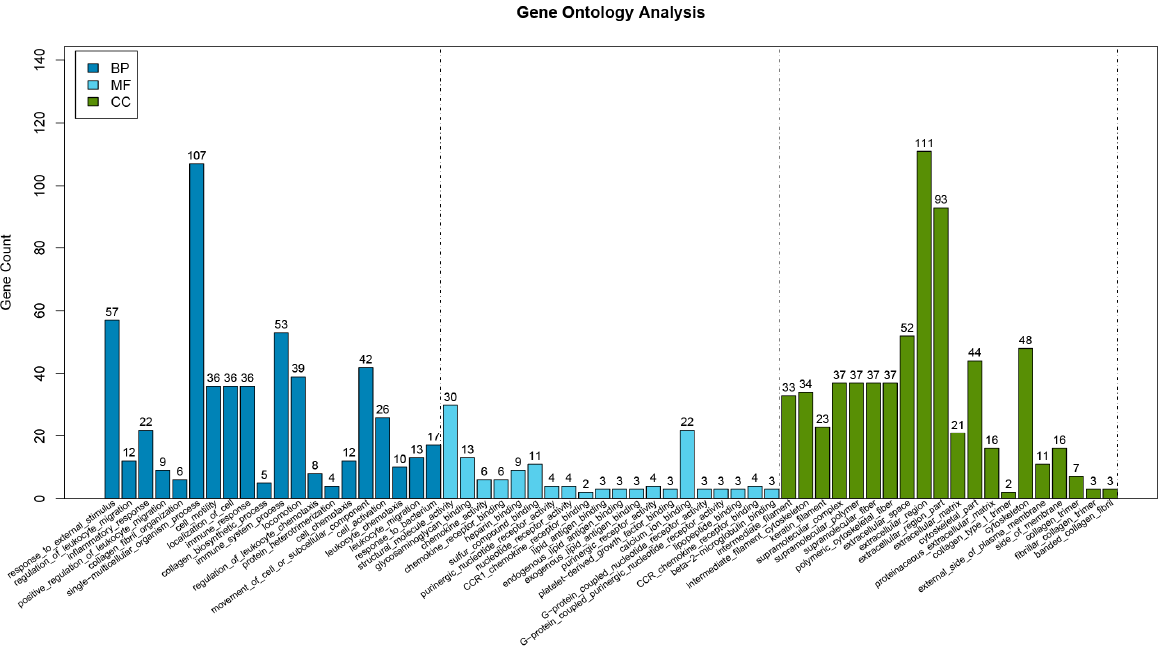
Figure 8. GO classification of differentially expressed lncRNAs target genes. Genes were enriched in cellular component (CC), molecular functional (MF), and biological function (BP).